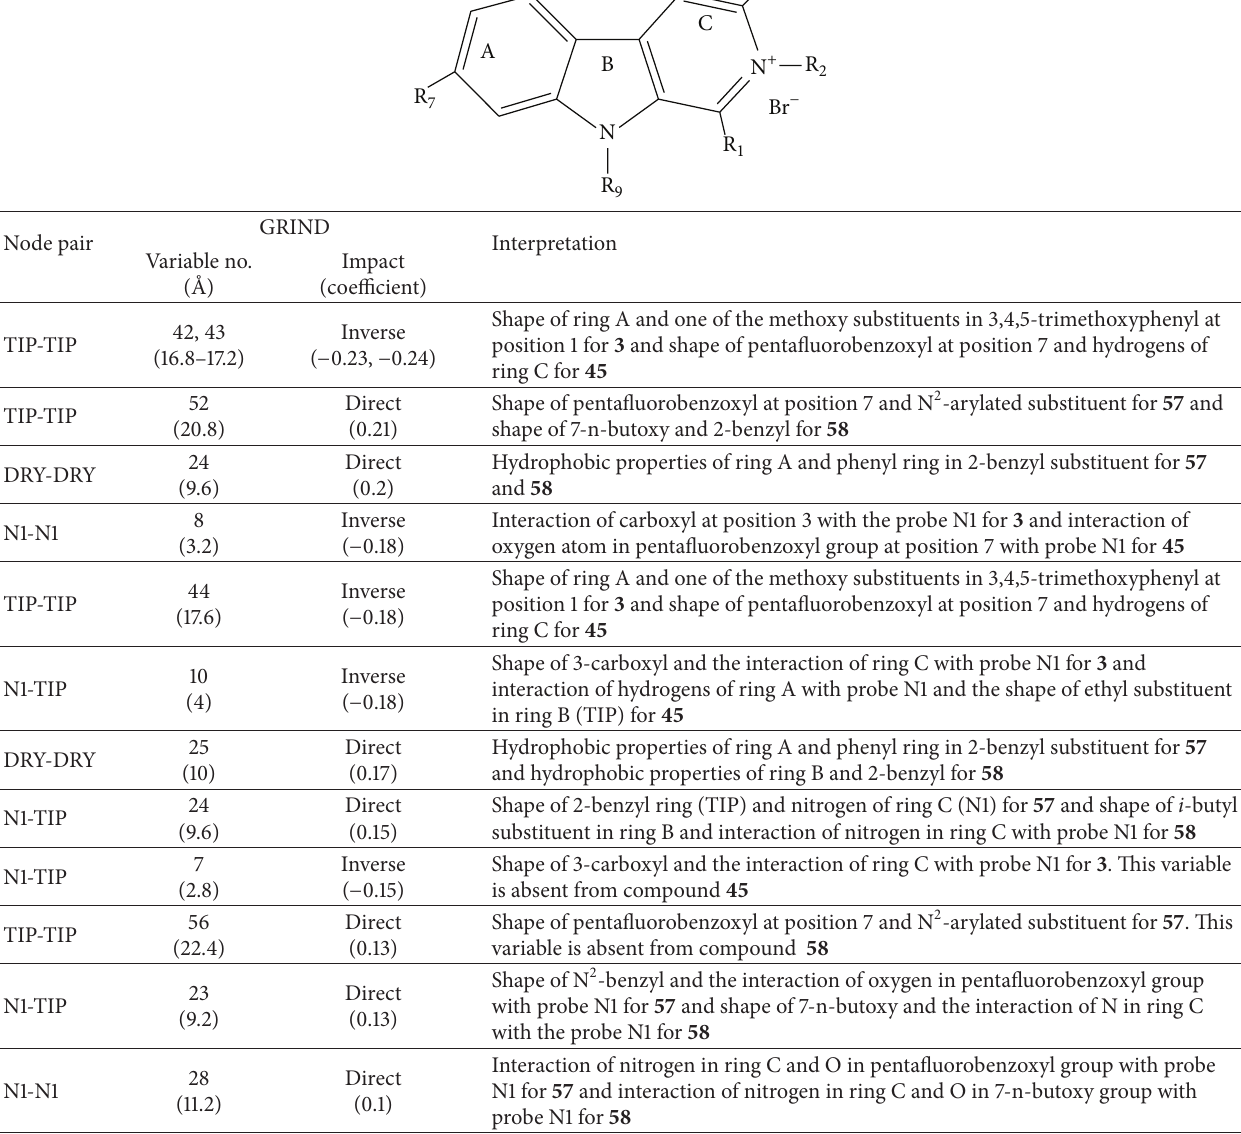
carefully inspected for these 8 compounds, including 4 active and 4 inactive 𝛽 -carboline derivatives (Figure 5). Variables with positive PLS coefficient should be present in active compounds and should be absent from inactive compounds and vice versa. Green boxes in Figure 5 represent presence or absence of variables as expected, and yellow boxes represent unexpected results. As it is shown, variables 44–52, 33–8, and 34–10 are the most discriminative variables. Since more than 65% of boxes are highlighted in green it can be concluded that the obtained model is very predictive and efficient. Also the yellow cells are a consequence of attempting a univariate interpretation of a multivariate